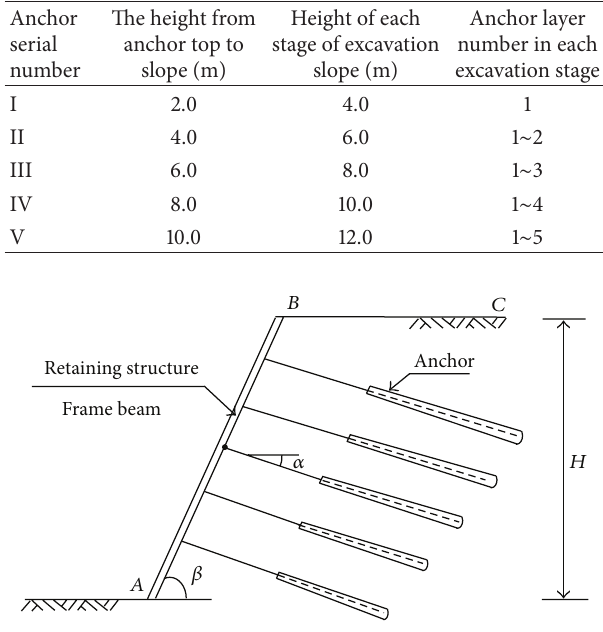
Figure 5: Scheme of slope